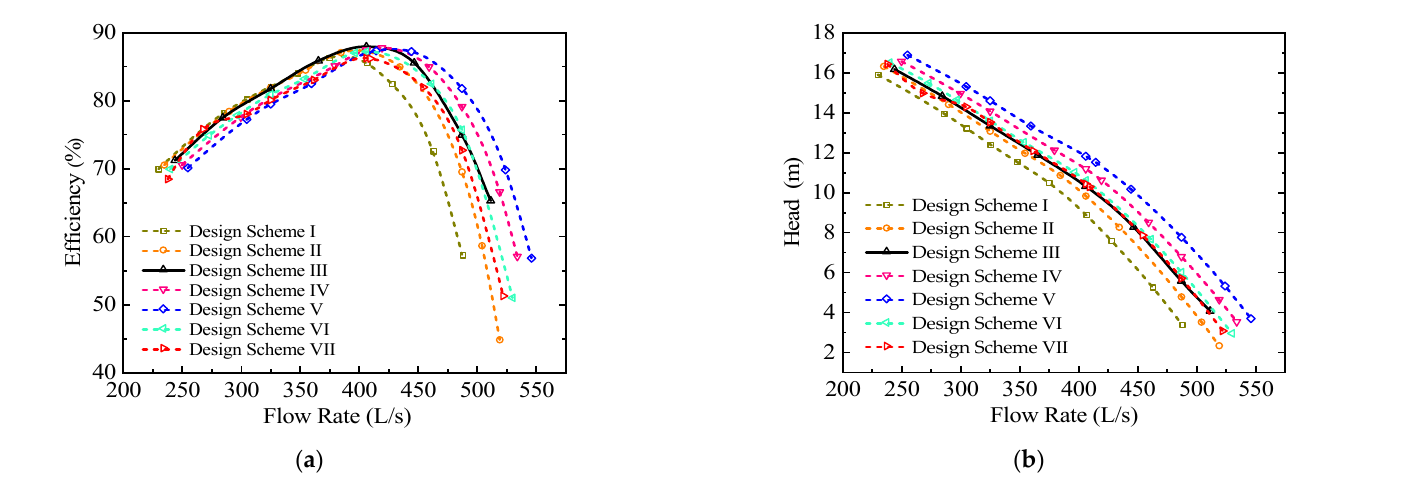
Figure 7. Energy performance curve of the mixed ‐ flow pump: ( a ) efficiency; and ( b ) head.